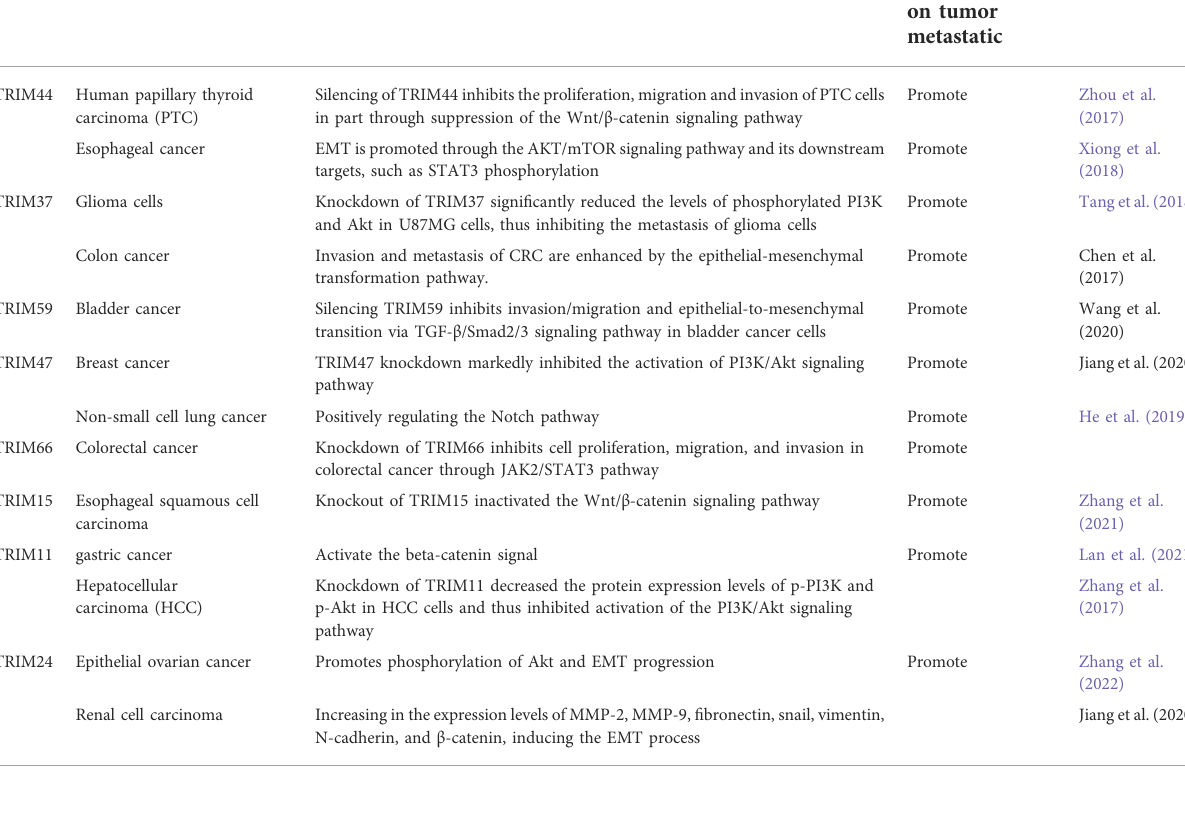
TABLE 3 Relationship between TRIMs and tumor metastasis.